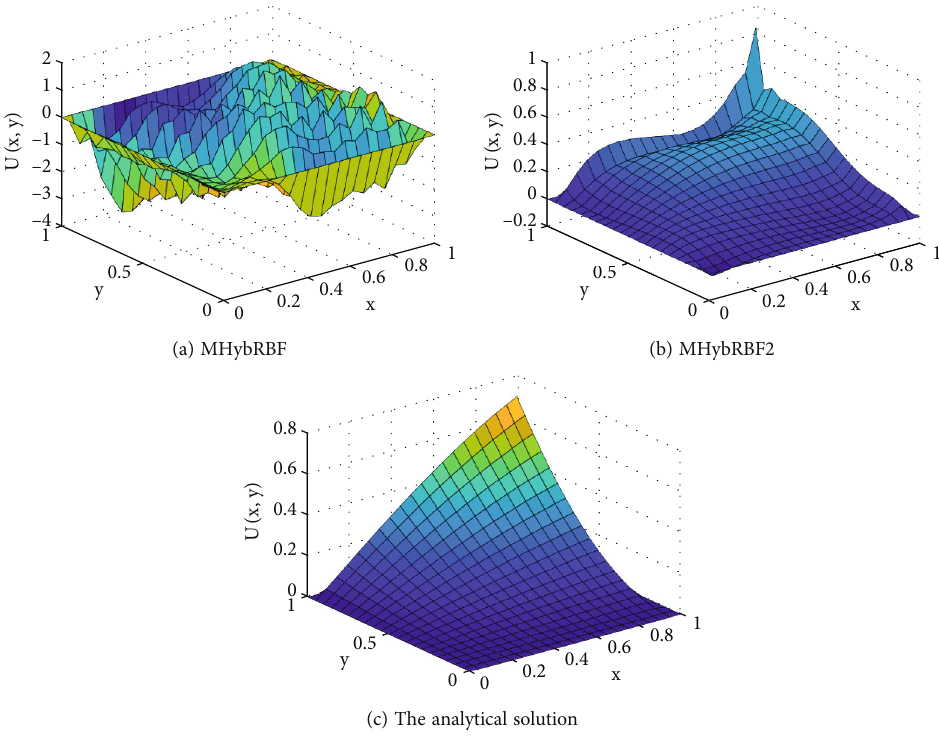
Figure 4: The approximate solution of MHybRBF and MHybRBF2 for ρ = 0 : 001 .